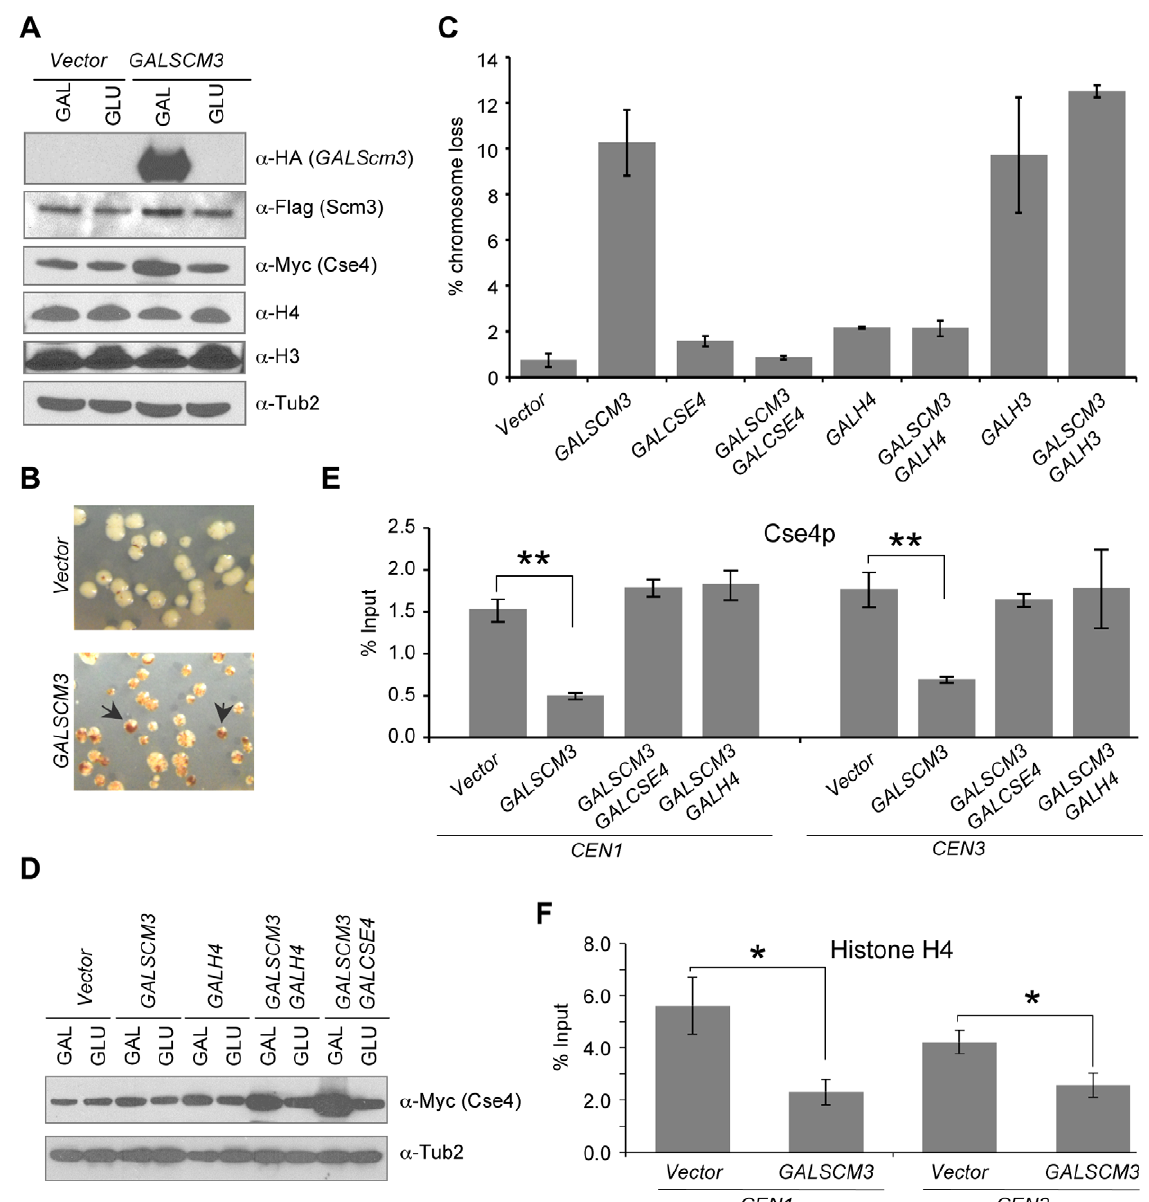
Figure 1. Overexpression of SCM3 causes chromosome instability and reduction in CEN -bound Cse4p and histone H4. (A) Western blot analysis was done using whole cell protein extracts prepared from wild type strains (RC154 or JG595) transformed with GALSCM3HA (pMB1306), or vector (pRS426 GAL1 ). Strains were grown to logarithmic phase of growth in synthetic media and gene expression induced in the presence of galactose (2%) at 30 u C for 12 hours. Blots were probed with anti-HA for expression of GALSCM3HA , anti-FLAG for expression of FLAG tagged Scm3p expressed from its own promoter, anti-Myc for expression of Cse4p, anti-H3 (abcam # ab1791-100) for expression of histone H3, anti-H4 (Millipore # 62-141-13) for expression of histone H4 and a -Tub2p served as a loading control. (B) Wild type strains with reporter chromosome fragment (YPH1018) expressing SCM3 from GAL1 promoter (pMB1306) or vector (pRS426 GAL1 ) were plated on SC-URA with limiting adenine and galactose (2%). Representative images showing red sectors in white colonies represent the loss of the non-essential chromosome fragment (CF). Arrows indicate colonies that show a half red-half white phenotype which represent CF loss in the first cell division. (C) GALSCM3- induces chromosome missegregation, which is suppressed by GALCSE4 and GALH4 . Quantification of chromosome loss by half-sector analysis. Reporter strains with chromosome fragment (YPH1018) transformed with vectors (pRS425 GAL1 , pRS426 GAL1 ), GALSCM3HA (pMB1306), GALCSE4 (pMB1147), GALSCM3HA , GALCSE4 (pMB1306, pMB1147), GALH4 (pMB1158), GALSCM3HA , GALH4 (pMB1306, pMB1158), GALH3 (pMB1159), and GALSCM3HA , GALH3 (pMB1306, pMB1159) were assayed for chromosome loss. At least 3000 colonies were counted and values represent the average 6 standard error for three independent transformants normalized to the value of 100. (D) Co-overexpression of histone H4 and SCM3 increases the levels of Cse4p. Western blot analysis was done using whole cell protein extracts prepared from a wild type strain (JG595) transformed with vector (pRS425 GAL1 ), GALSCM3 (pMB1193), GALH4 (pMB1158), GALSCM3 , GALH4 (pMB1193, pMB1158), and GALSCM3 , GALCSE4 (pMB1193, pMB976). Strains were grown to logarithmic phase of growth in media selective for the plasmid and gene expression induced in the presence of galactose (2%) at 30 u C for 12 hours. Blots were probed with anti-Myc for expression of Myc tagged Cse4p expressed from its own promoter and a -Tub2p served as a loading control. (E) GALSCM3 strains show reduced levels of CEN -associated Cse4p. ChIP experiments were done using wild type strain expressing Cse4p-Myc from its